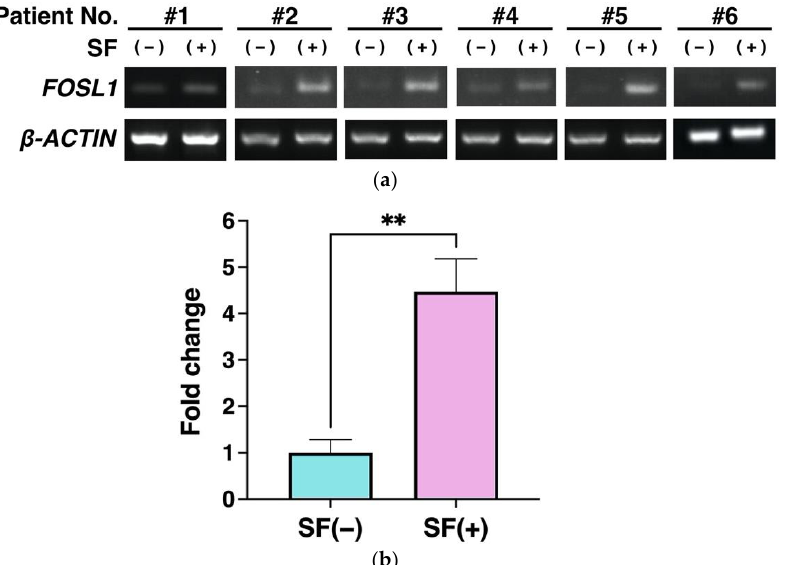
Figure 4. Validation of FOSL1 expression using RT-PCR. ( a ) Agarose gel electrophoresis of the PCR products. ( b ) Bar graph showing the results of quantification of six samples ( a ). Gene expression was normalized to β-ACTIN expression. Data are expressed as the mean ± S.D. ** p < 0.01 is shown.